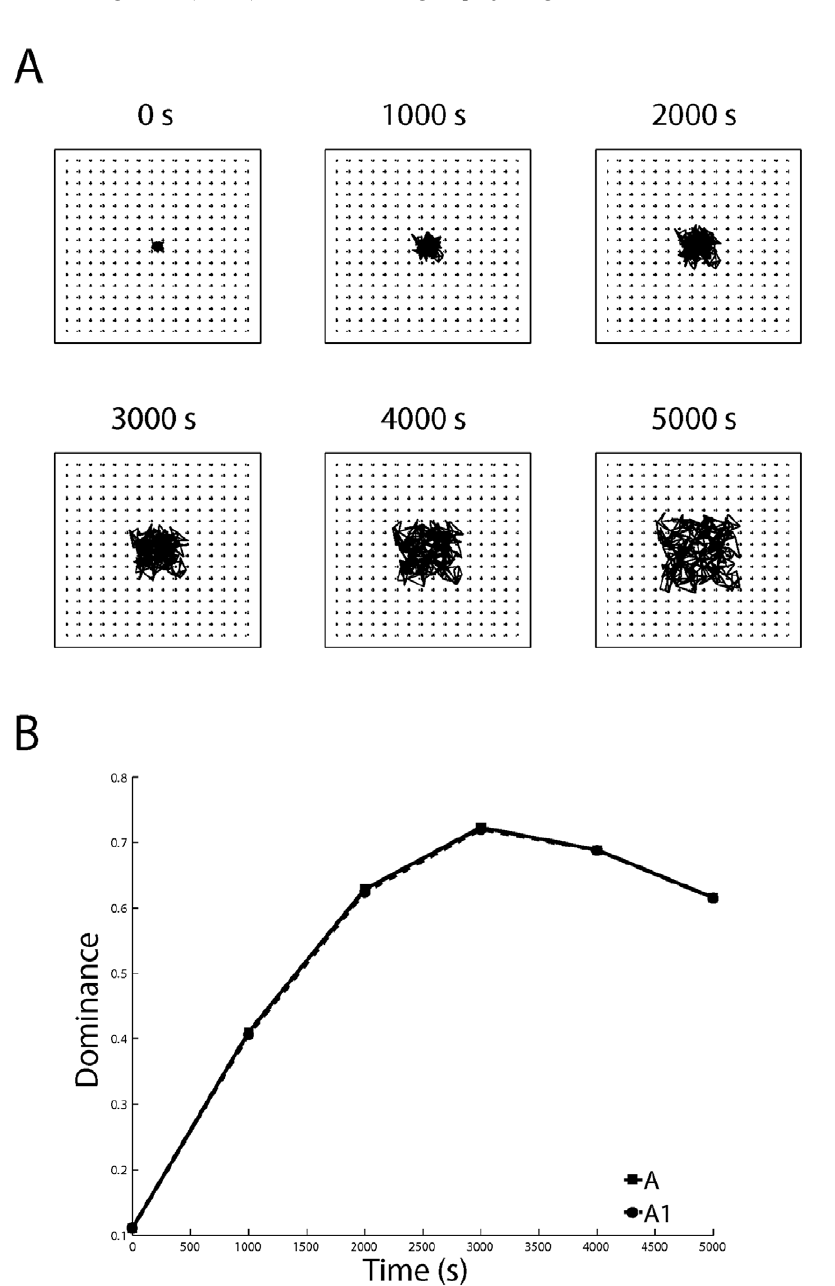
Figure 11. A proper topography fails to develop in the absence of structured retinal input. In these simulations, the dLGN received interleaved Poisson noise from each eye instead of retinal waves (thus preserving the anti-correlated activity between retinas). (A) The CoMs do not approach the grid as in Figures 9 and 10 (normal and accelerated waves), yet (B) the proper eye-specificity develops. doi:10.1371/journal.pone.0031553.g011 PLoS ONE |